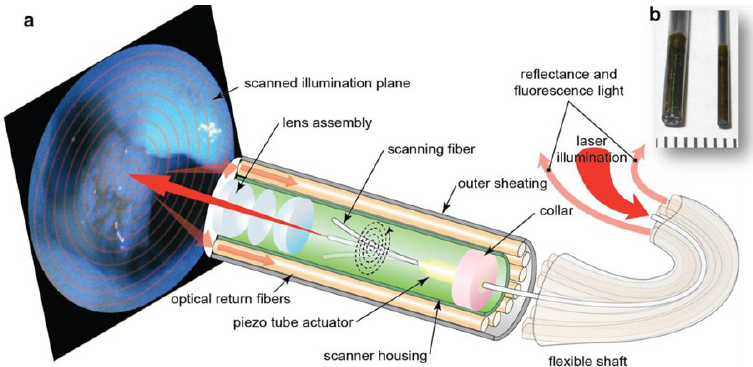
Figure 16. Scanning fiber endoscope optics and fluorescence spectrometry of major structural constituents of atherosclerotic plaques. ( a ) The scanning fiber endoscope excites tissues by scanning blue (424 nm), green (488 nm), and red lasers (642 nm) in a spiral pattern. Backscattered (reflectance) light and fluorescent signal is collected by a ring of optical fibers located in the periphery of the scanner housing and shaft, and conducted to a computer for image generation. ( b ) The optical system can be mounted in 2.1 mm (left) or 1.2 mm (right) endoscopes. Reproduced with permission from [91]; published by Nature, 2017.